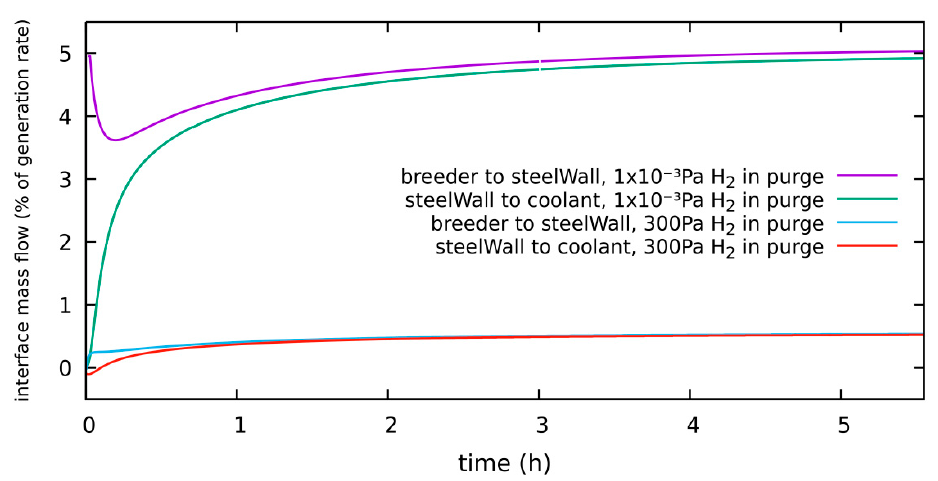
Figure 8. Transient tritium flow through patch interfaces breeder to and from steel, and steel to and from coolant for 1 × 10 − 3 Pa vs. 300 Pa H 2 in the purge gas.